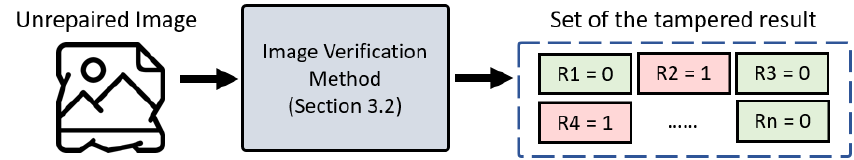
Figure 10. Process of getting the tampered result of tampered image.